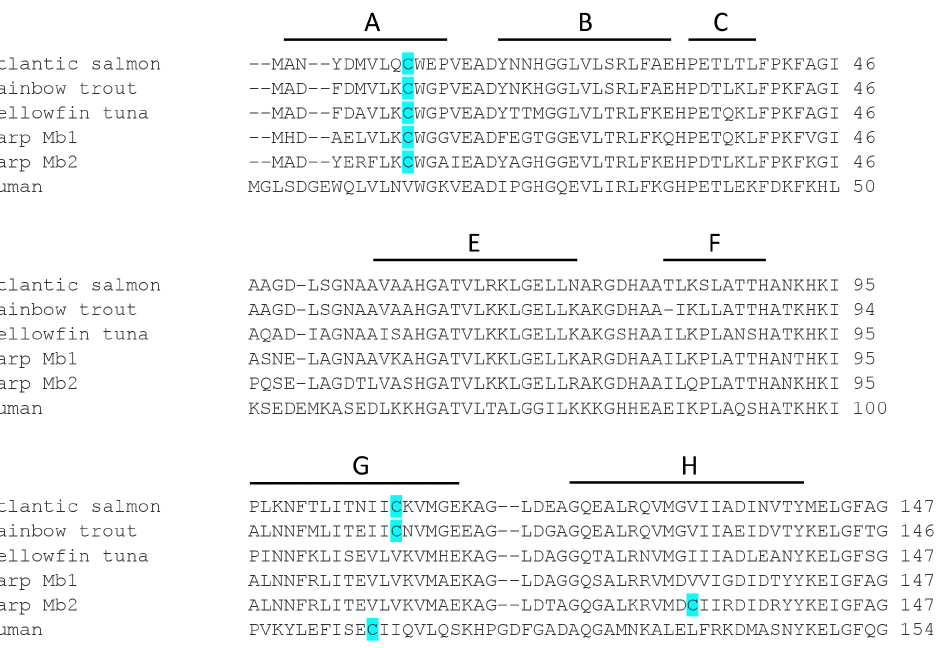
Figure 1. Amino acid sequence alignment of salmon, trout, tuna, carp Mb1 and Mb2 and human Mb shows variable number and position of Cys residues (highlighted). Mb sequences have been retrieved from Pub Med (Atlantic salmon: Atlantic salmon: GenBank, ACM09229.1, rainbow trout: GenBank, BAI45225.1, yellowfin tuna: GenBank: AAG02112.1, common carp Mb1: UniProtKB/Swiss-Prot, P02204.2, common carp Mb2: GenBank: ABC69306.1, human: NCBI Reference Sequence: NP_976311.1). The positions of the a -helices (A–C, E–H) are indicated and are based on the structure of yellowfin tuna Mb [18].